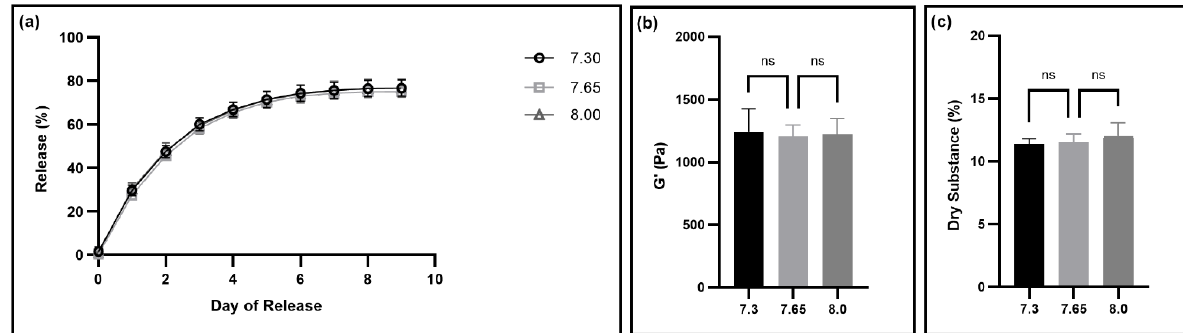
Figure 3. Evaluation of the impact of gel pH on gel properties. ( a ) The release profiles of fluorescein with N = 6. Error bars hidden by plot symbols when not visible. A one-way ANOVA was used to compare release from gels adjusted to different pH values, indicating no statistically significant difference between the release profiles (Table S3). ( b ) Storage moduli for gels made by adjusting to different pH values. Mean and standard deviation are displayed from data collected with N = 6. A one-way ANOVA was used to compare the means, with ns indicating no significant difference between the means. ( c ) Dry substance percentage for gels made by adjusting to different pH values. Mean and standard deviation are displayed from data collected with N = 6. A one-way ANOVA was used to compare the means, with ns indicating no significant difference between the means.